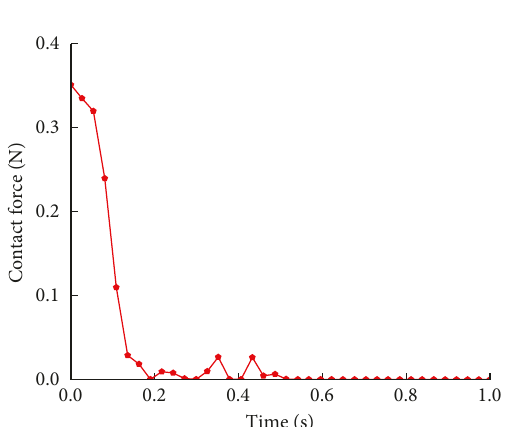
Figure 6: The contact force variation of characteristic particle